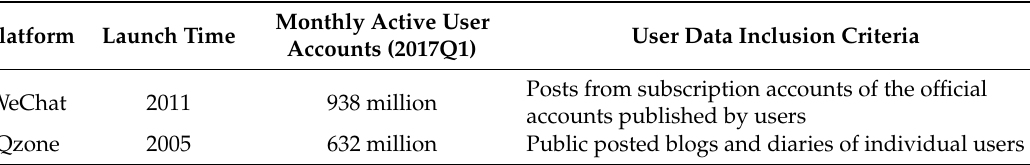
Table 1. Data sources.